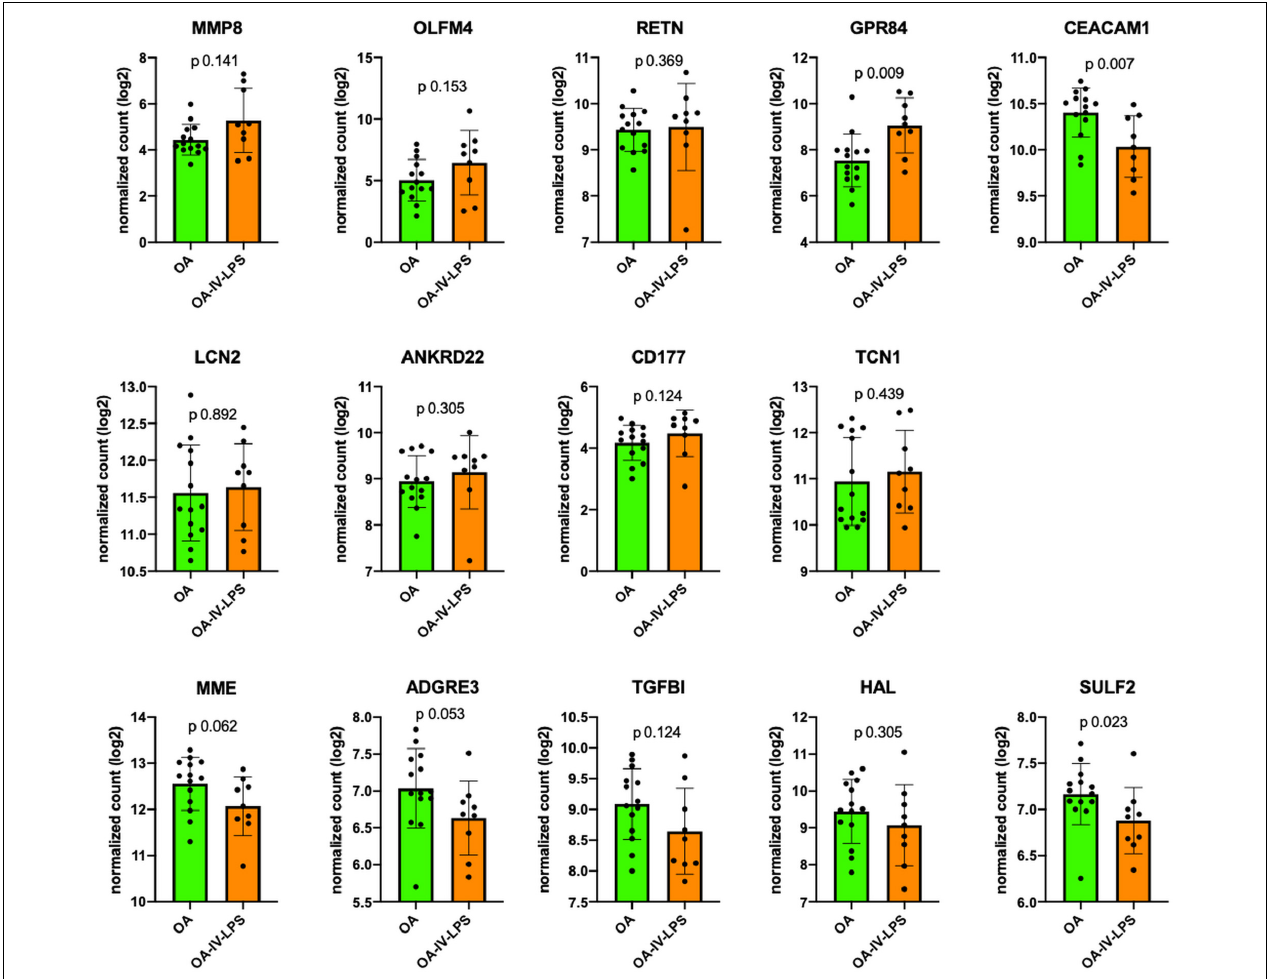
FIGURE 2 | Comparison of mRNA expression markers between animals injured with OA (=Ph1) and OA-IV-LPS (=Ph2; in all animals, all time points of tissue harvesting). Figure legend: y -axis displays log2 normalized count of the respective mRNA marker at all sampling times (6 h: Ph1 n = 5, Ph2 n = 3; 12 h: Ph1 n = 4, Ph2 n = 3; 24 h: Ph1 n = 5, Ph2 n = 3). Error bar displays standard deviation, p value for comparison using Mann–Whitney U test. Abbreviations: OA, oleic acid; OA-IV-LPS, oleic acid and lipopolysaccharide intravenously; MMP8, matrix metalloproteinase 8; OLFM4, olfactomedin; RETN, resistin; GPR84G, protein-coupled receptor 84; CEACAM1, CEA cell adhesion molecule 1; LCN2, lipocalin 2; ANKRD22, ankyrin repeat domain 22; CD177, CD177 molecule; TCN1, transcobalamin 1; MME, membrane metalloendopeptidase; ADGRE3, adhesion G protein-coupled receptor E3; TGFBI, transforming growth factor beta induced; HAL,